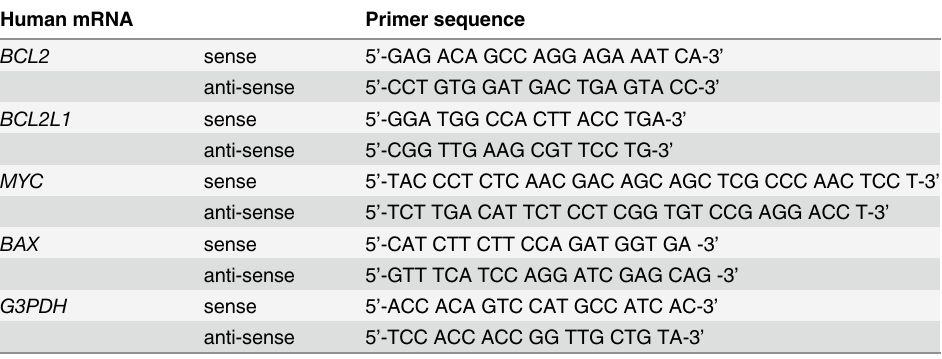
Table 1. Nucleotide sequences of primer pairs used in this